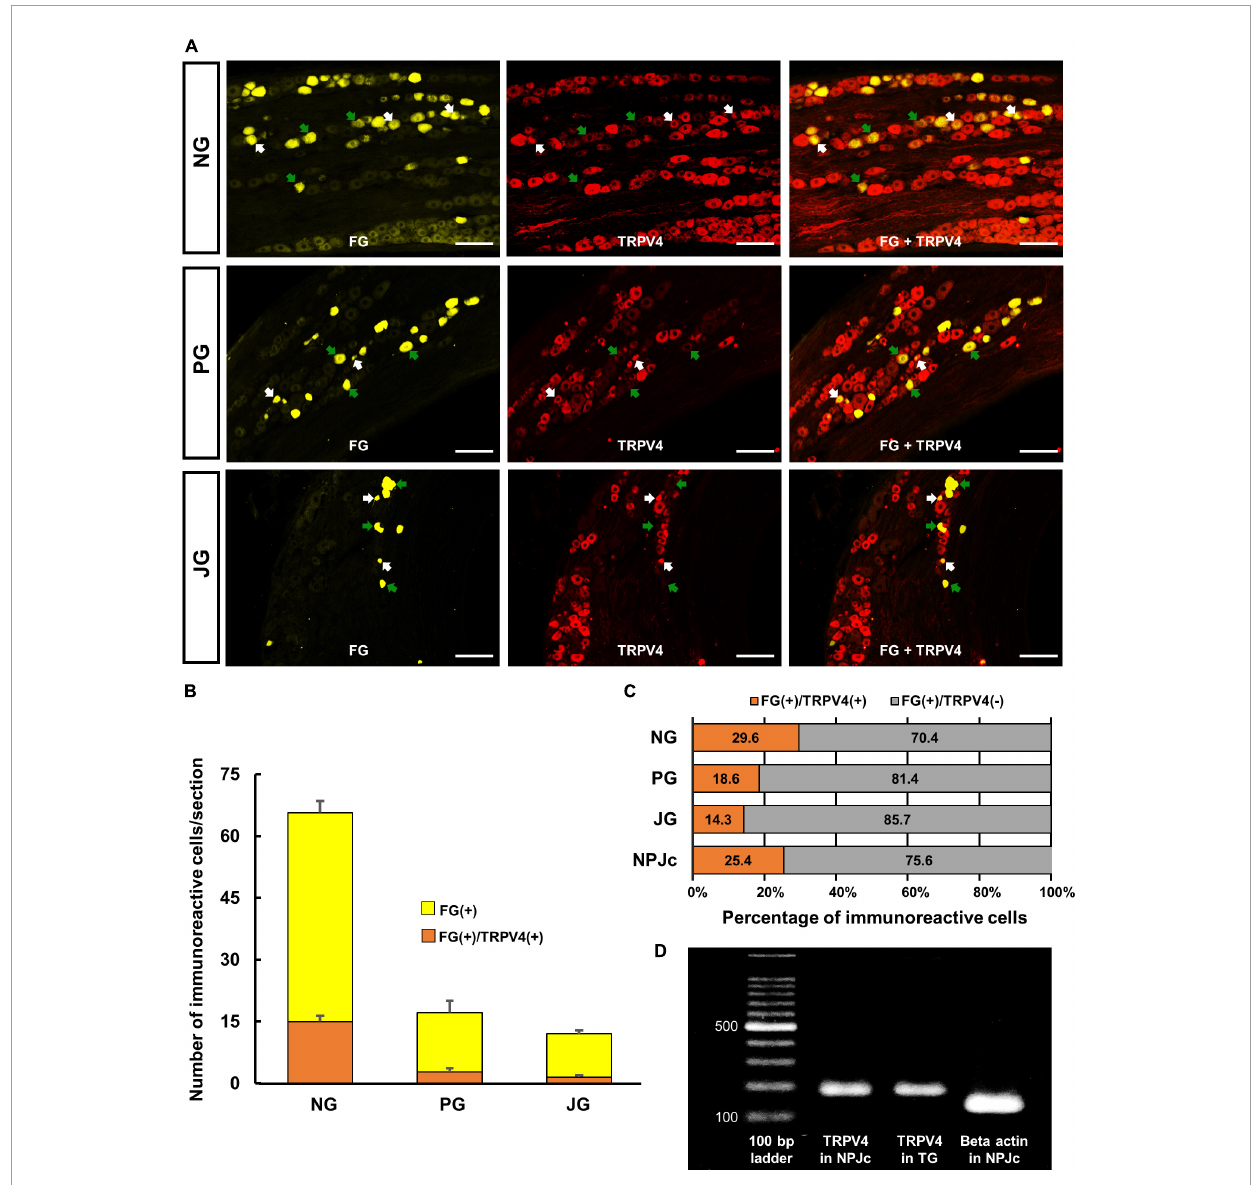
FIGURE2 TRPV4 localized on SLN-afferent neurons in the NPJc. (A) Expression of TRPV4 in the nodose ganglion (NG), petrosal ganglion (PG), and jugular ganglion (JG). White arrows indicate cells positive for fluorogold (FG) and TRPV4. Green arrows indicate cells positive for FG but negative for TRPV4. Scale bars = 100 µ m. (B) The number of TRPV4-positive cells/section in the NG, PG, and JG. Data are presented as the mean ± SEM. n = 5. Sections showing the highest number of TRPV4-immunoreactive cells were used for cell counting. Six sections were used from each rat (two sections/ganglion). (C) Percentage of FG-stained, TRPV4-positive, or TRPV4-negative cells. FG(+), cells stained with FG; FG(+)/TRPV4(+), FG-stained cells immunopositive for TRPV4; FG(+)/TRPV4(–), FG-stained cells immunonegative for TRPV4. (D) TRPV4 mRNA in NPJc and trigeminal ganglion (TG). TG was used as a positive